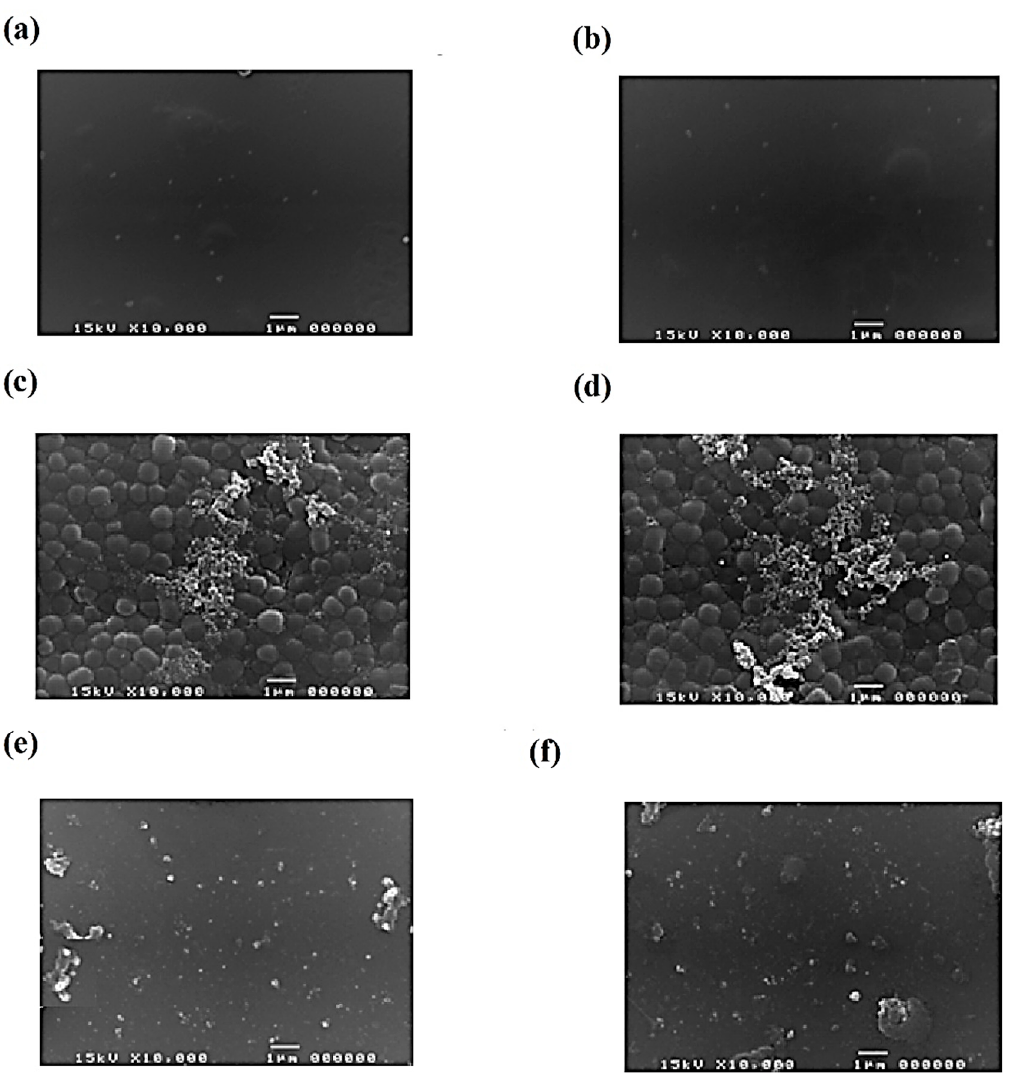
Figure 2. The scanning electron microscopy pictures show the efficacy of mouthwash formulation I ( a , c , e ) and II ( b , d , f ) against S. mutans biofilm. Positive control ( a , b ), negative control ( c , d ), and test ( e , f ). The treatment of mouthwash formulations effectively suppressed the formation of biofilm. Scale bar = 1 µm.